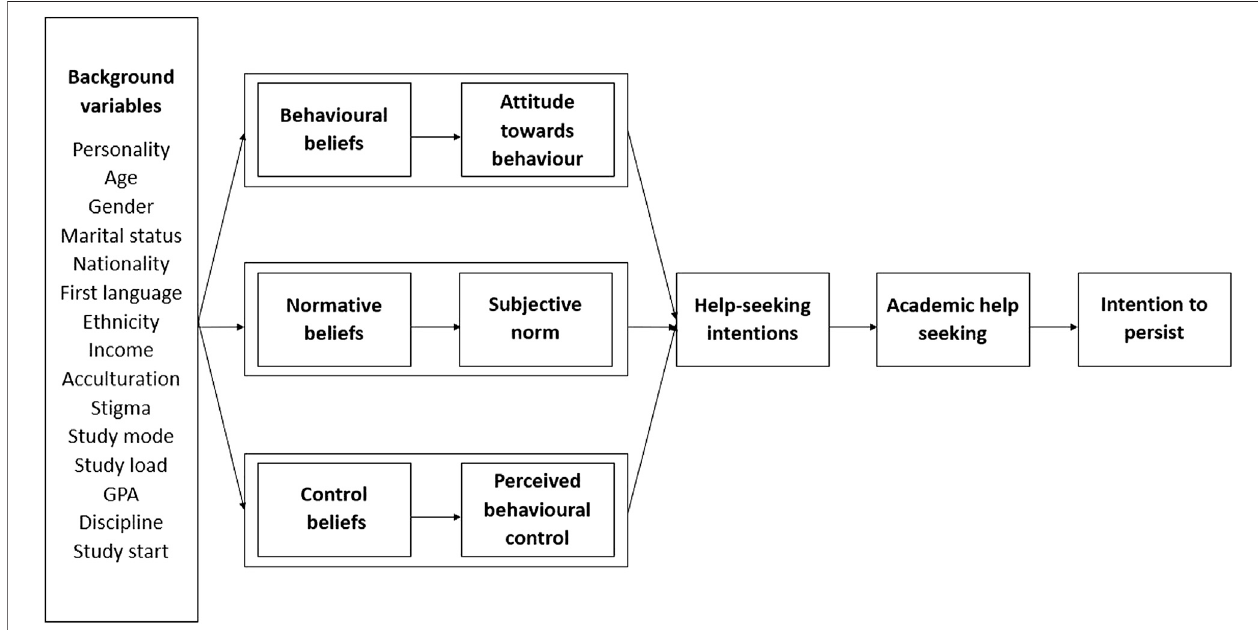
FIGURE 1 | The Theory of Planned Behavior in the context of academic help seeking [adapted from Ajzen (2005), p. 135].